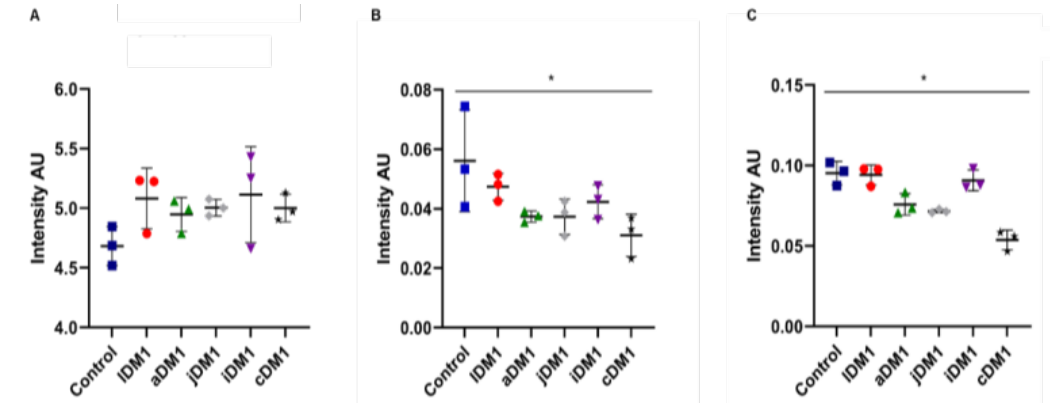
Figure 6. Scatter dot plot of DM1-derived fibroblasts and control ratios. ( A ) CH 2 /CH 3 ratio ( B ) Unsaturated/Saturated ratios of ( C ) Carbonyl/Total lipid ratio. * p ≤ 0.05. AU—arbitrary units; Control ( (cid:4) ); lDM1—late-onset DM1 ( • ); aDM1—adult-onset DM1 ( (cid:78) ) ; jDM1—juvenile-onset DM1 ( (cid:7) ); iDM1—infantile-onset DM1 ( (cid:72) ); cDM1—congenital-onset DM1 ( (cid:70) ).